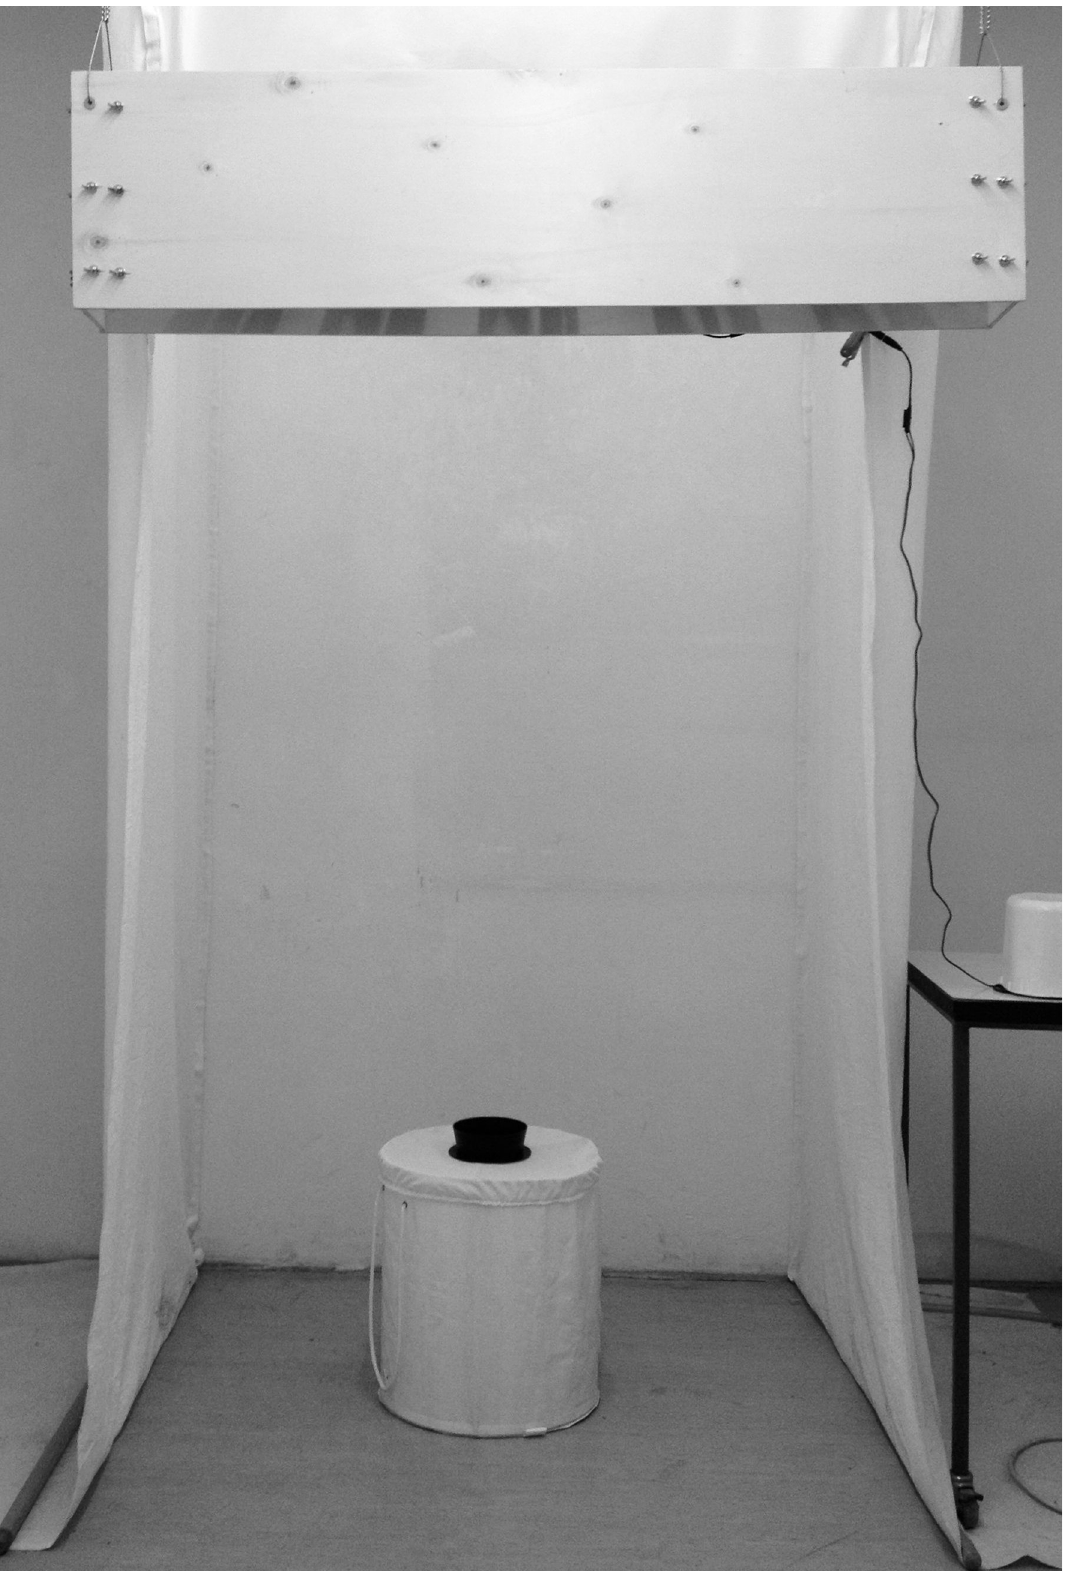
Fig 1. Laboratory test set-up showing the tent structure, BGS trap and FFS (front view). doi:10.1371/journal.pone.0129878.g001 PLOS ONE | DOI:10.1371/journal.pone.0129878 June 26,